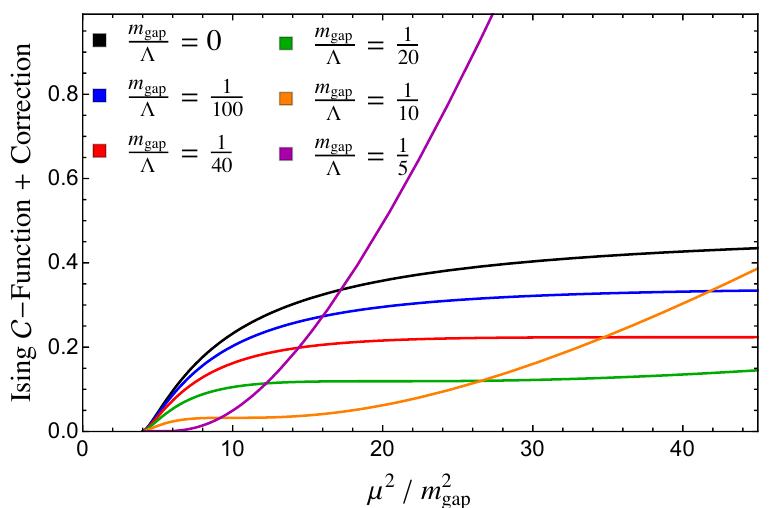
Figure 11 . Theoretical prediction for the Zamolodchikov C -function in the Ising model e(cid:11)ective theory, including the correction from the leading irrelevant operator, for di(cid:11)erent values of m gap In the limit (cid:3) ! 1 (black curve), the function levels out and approaches the Ising central charge c Ising = 1 . For (cid:12)nite values of (cid:3), the corrections dramatically alter the function, lowering the 2 plateau and eventually completely eliminating it as (cid:3) ! m gap